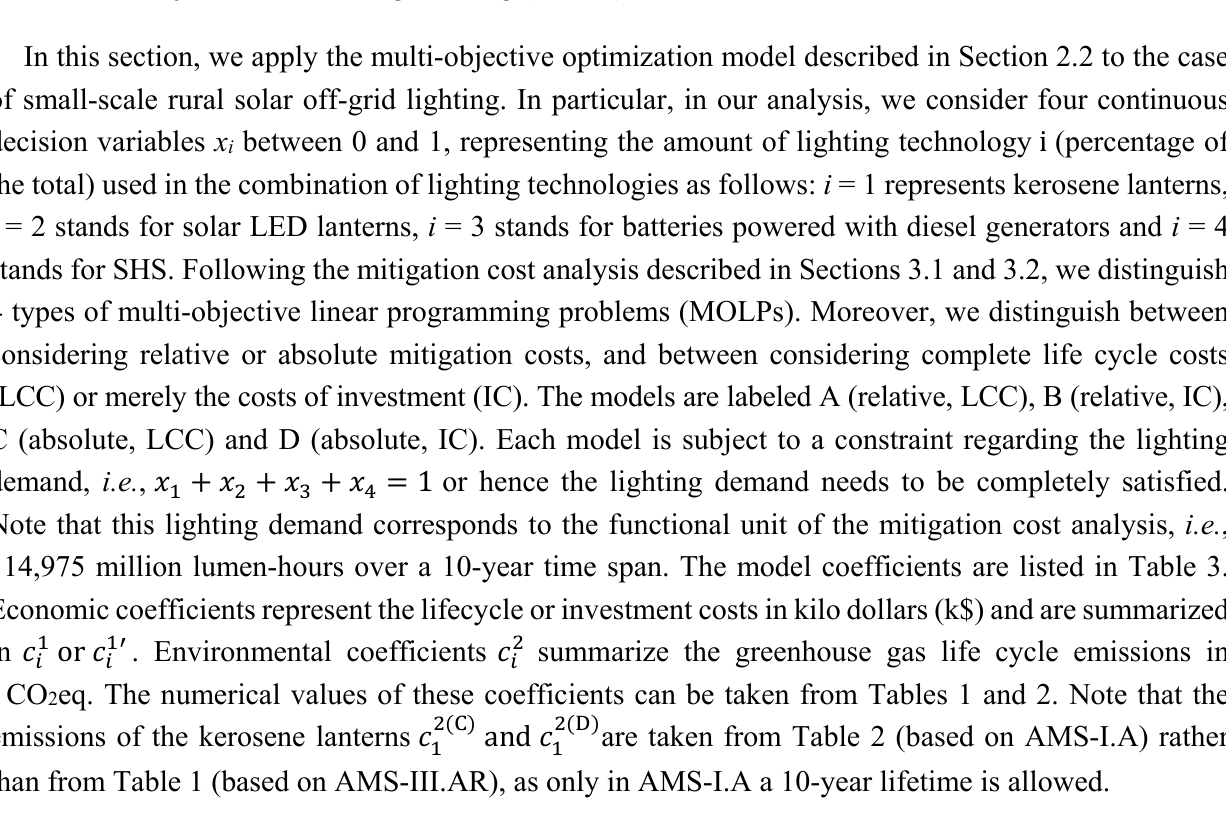
Table 3. Decision variables and coefficients of the multi-objective linear programming (MOLP)